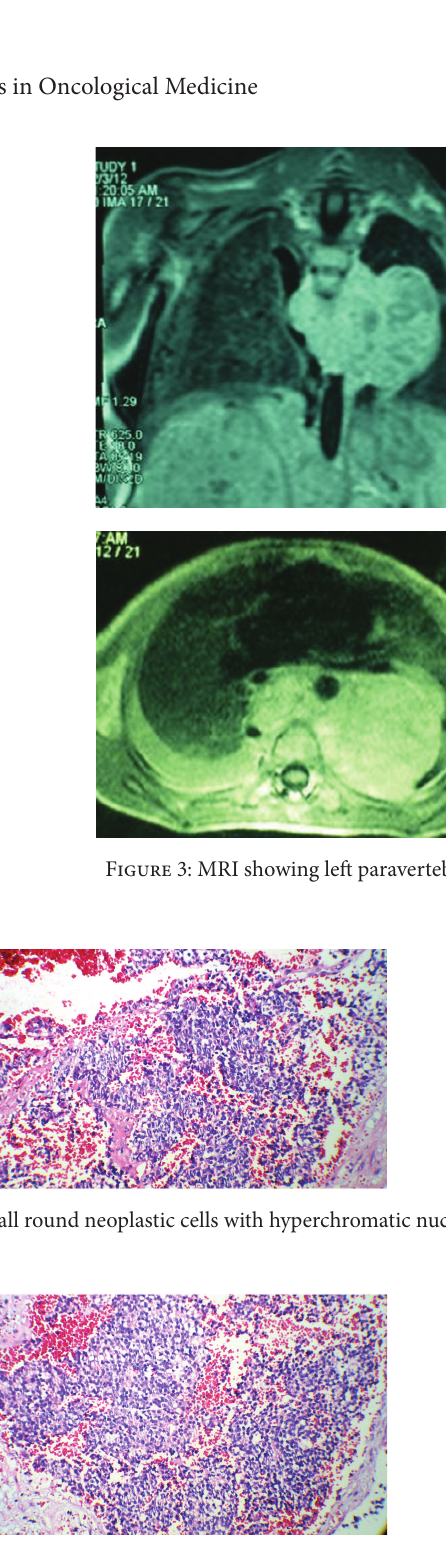
Figure 7: Synaptophysin immunohistochemistry in tumor